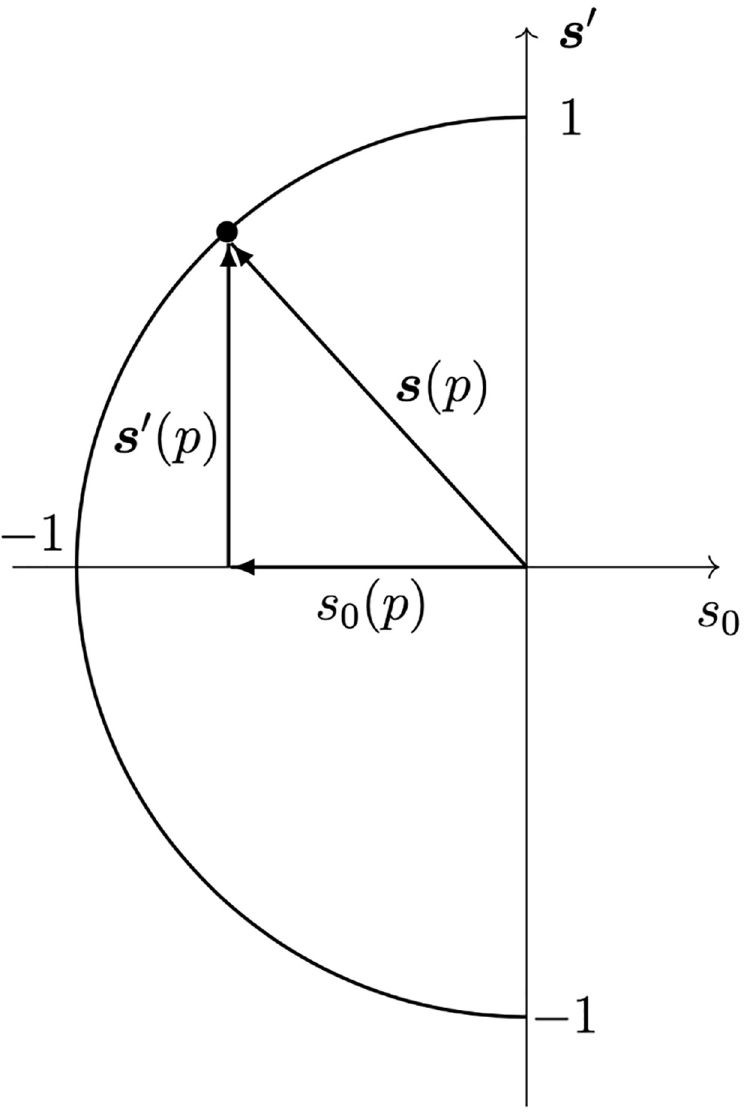
Fig 1. Schematic of the unit preference vector s( p ) of household p , its component s 0 ( p ) and the multidimensional remainder vector s 0 ( p ). As s 0 ( p ) approaches − 1 wealth decreases and the magnitude of remaining preferences j s 0 ( p ) j is reduced accordingly; the richest households have j s 0 ( p ) j �